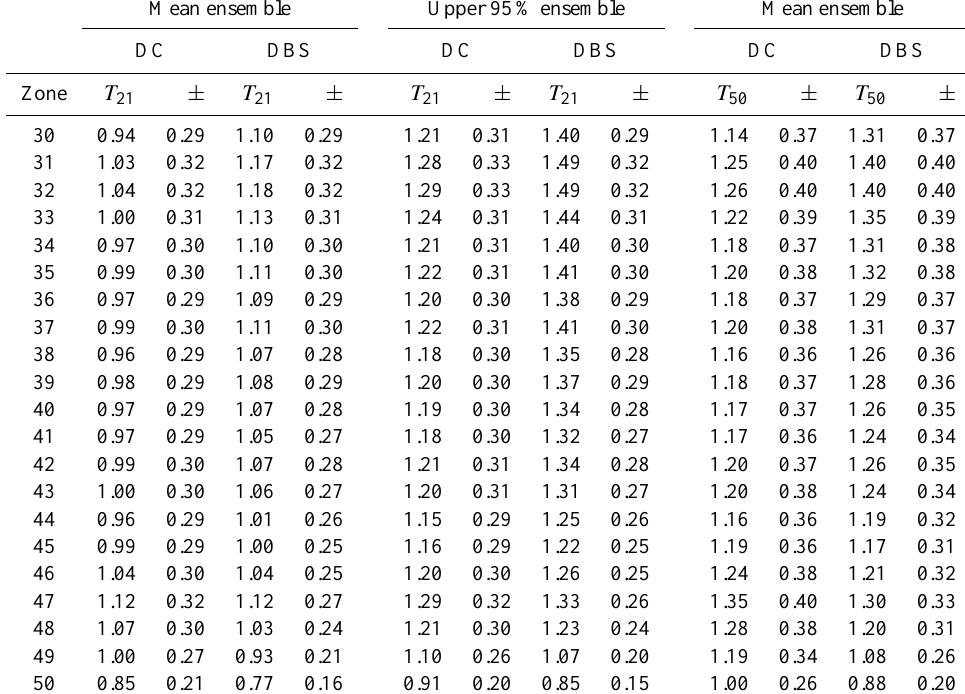
Table 3. Estimated future (2081–2100) extreme groundwater levels and associated Gumbel (EVA) error bounds ( ± ) in m for return periods of 21 ( T 21 ) , 50 ( T 50 ) and 100 ( T 100 ) years for zones 30–50 along the motorway. Values are relative to present mean groundwater level at each